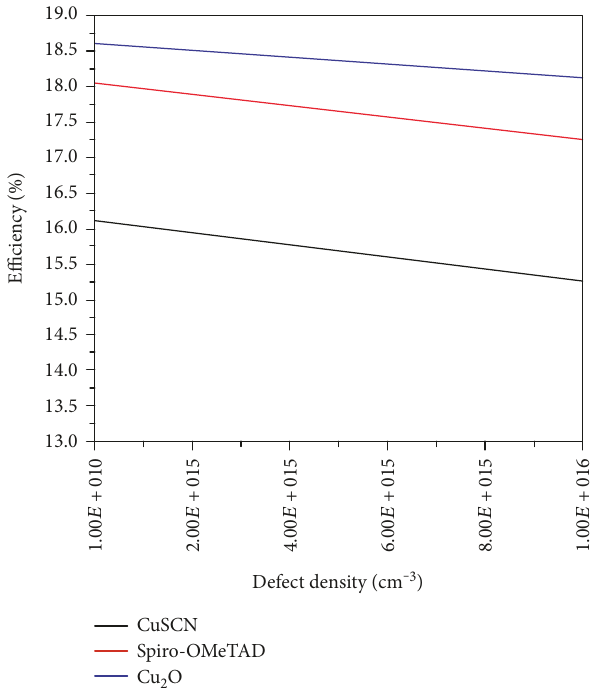
Figure 5: Defect density of the ETM/CH e ffi